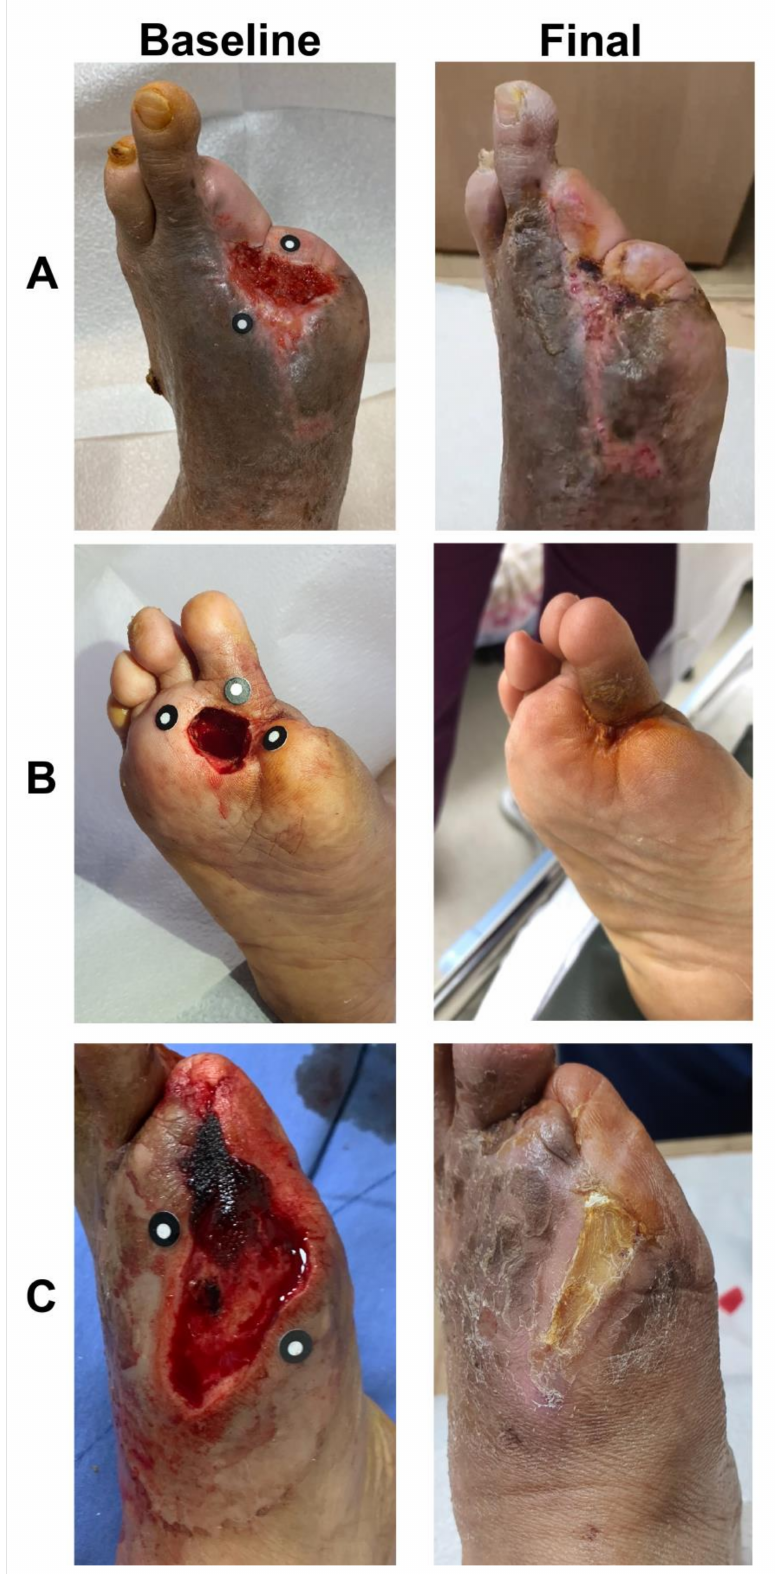
Figure 6. Three representative examples of micronized adipose tissue niche grafts of diabetic foot ulcers. Baseline: before treatment. Final: after treatment at the first closure at 6, 10, and 11 weeks in Patients ( A ), ( B ), and ( C ),